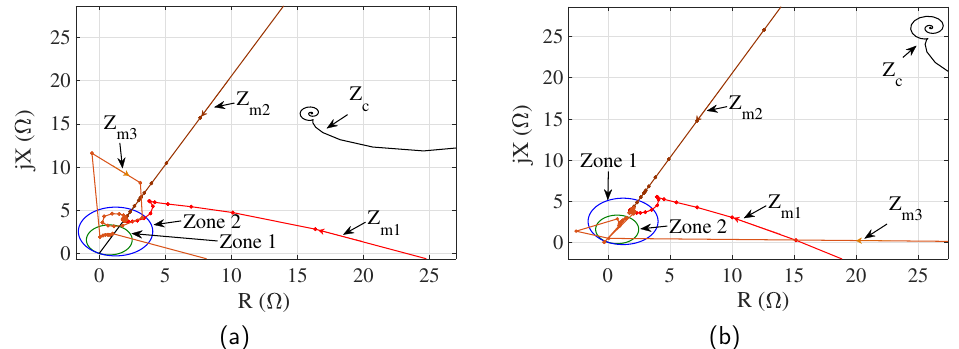
Figure 20. Impedance trajectories of the proposed and conventional methods for ( a ) 3LG and ( b ) SLG faults at 100% of the feeder’s